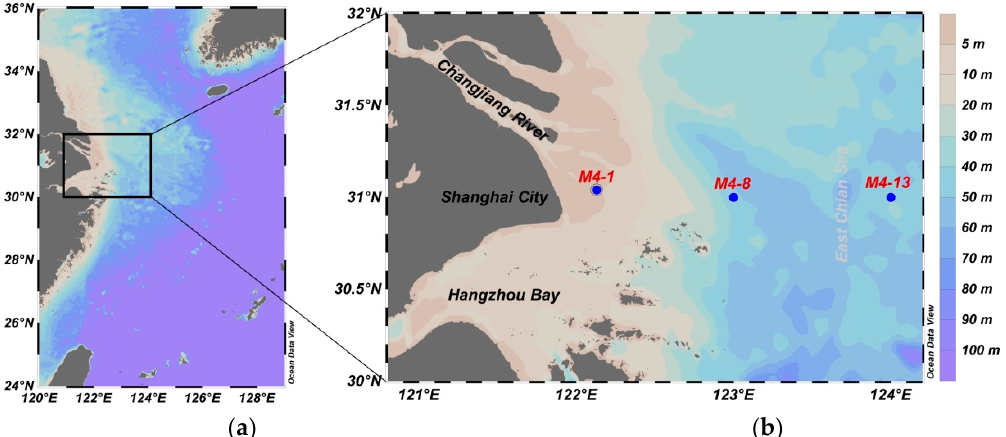
Figure 1. Map of Changjiang River estuary plume ( a ) and sampling stations ( b ): stations M4-1, M4-8, and M4-13 denote the near-shore, front, and offshore regions, respectively.